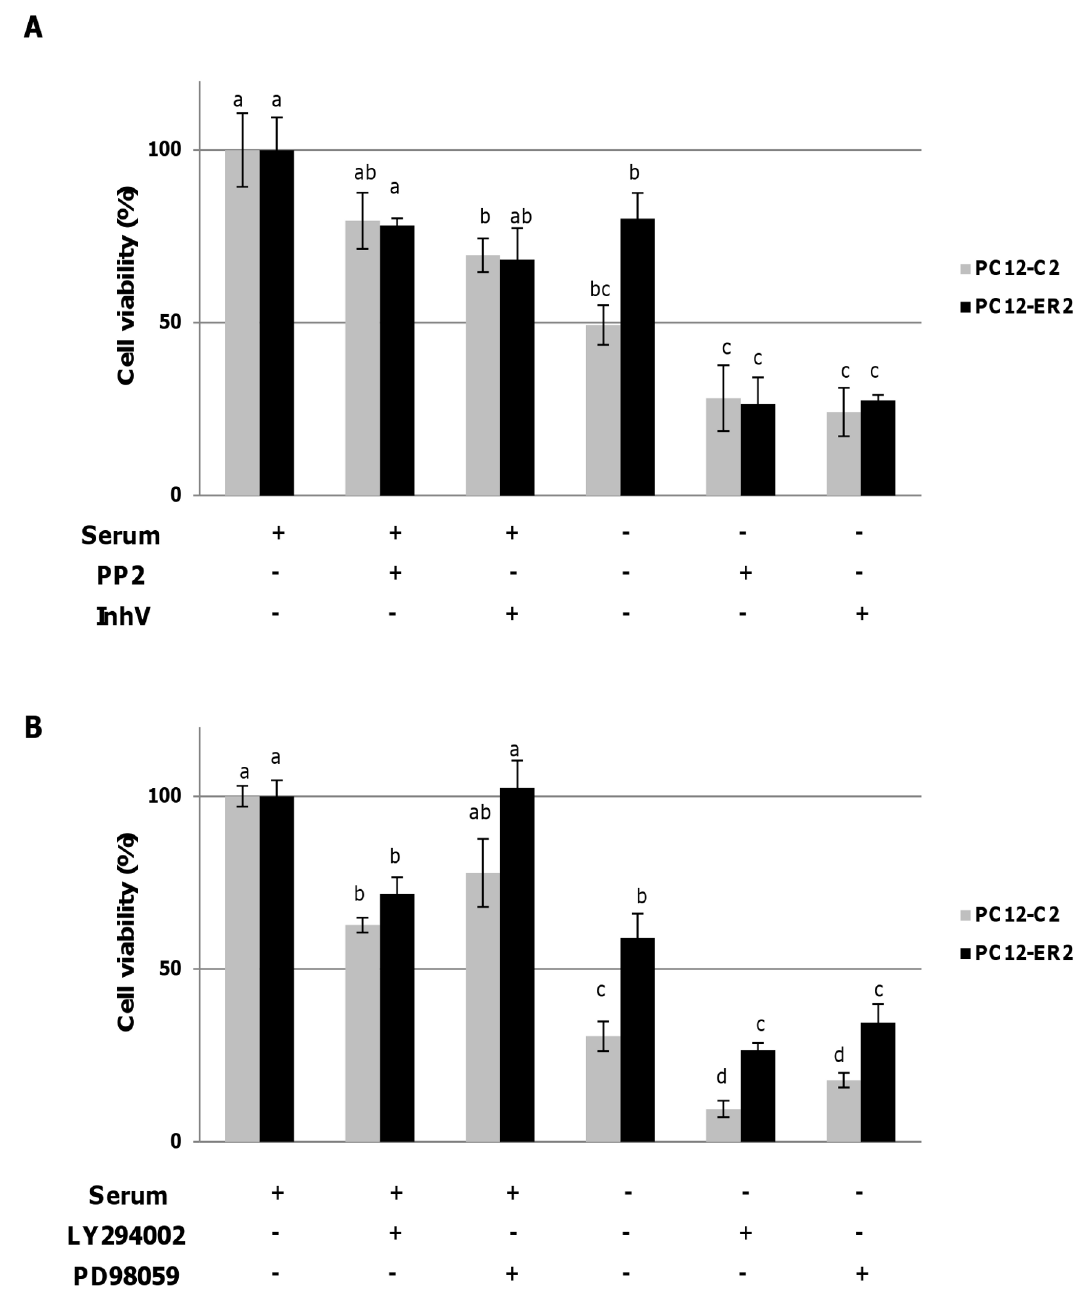
Figure 3. The protective effect of unliganded-ERα depends on c-Src and Stat3 activities. PC12-C2 and PC12-ER2 cells were grown in medium with or without FCS for 24 hrs, in the presence of inhibitors of c-Src or Stat3 (respectively PP2 and InhV, panel A) or inhibitors of PI3K/Akt or Mek/Erk (respectively LY294002 and PD98059, panel B). Cell viability was then assessed using ViaLight HS kit (Lonza). Results were expressed in cell viability in percent relatively to the viability of the same cells maintained in medium containing FCS without inhibitors. Values correspond to the mean ± SEM of three separate experiments. No significant interaction occurred following 2 way AOV between treatments with PP or InhV and ER expression. Columns with different superscripts differ 2 significantly (p<0.05 by Student test).